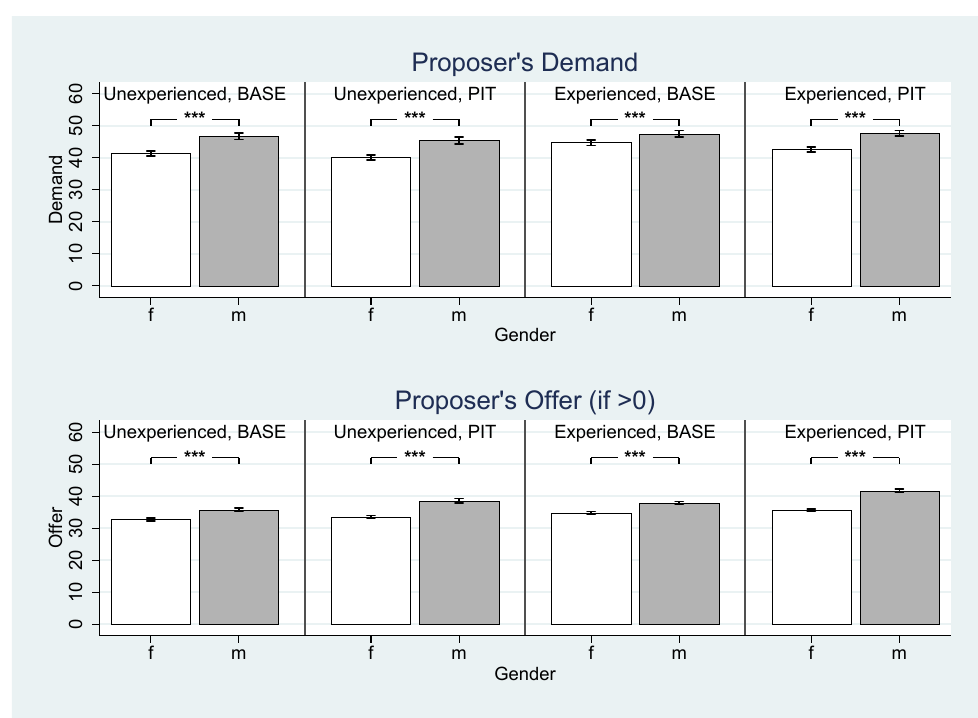
Figure 3. Proposer Behavior by Experience, Treatment, and Gender. Upper panel: average demand in tokens; lower panel: average offer in tokens. The number of observations for each bar, means, and standard errors, as well as t -tests can be taken from Table A5 in Appendix A. Significance levels: * p ≤ 0.10, ** p ≤ 0.05, and *** p ≤ 0.01. Error bars represent 90% confidence